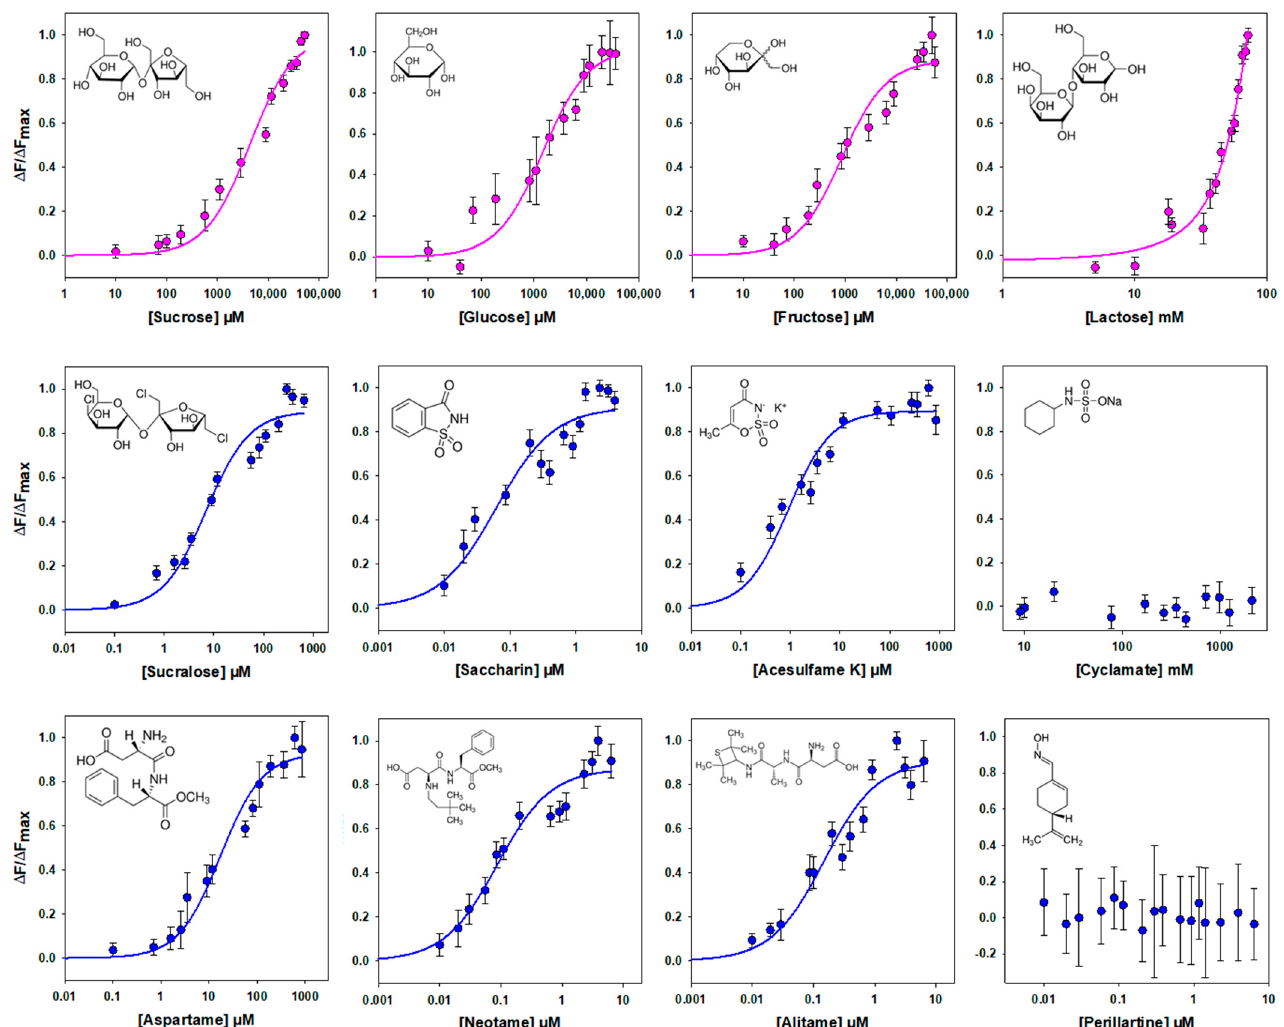
Figure 4. Binding properties of hTAS1R2-VFT assessed by intrinsic tryptophan fluorescence. Titration curves of hTAS1R2-VFT were generated with natural sugars (pink circles) or sweeteners (blue circles). Circles show experimental data, while the solid lines are the computed binding curves; excitation and emission wavelengths were 295 nm and 340 nm, respectively; hTAS1R2-VFT concentration, 0.5 µM. Data points correspond to the means ± SEMs of at least 12 independent replicates of at least three independently refolded protein samples, except for glucose, 6 independent replicates over three independently refolded protein samples.